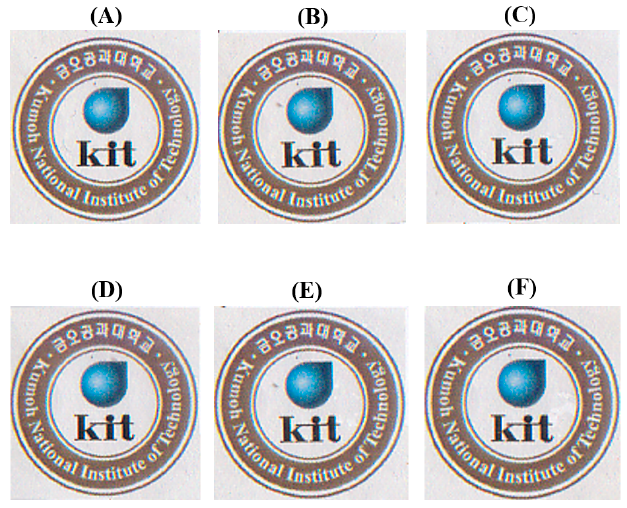
Figure 4. Photographic images of the various Co-PI films over the Kumoh National Institute of Technology logo. Samples ( A – F ) are in accordance with the composition shown in Table 1.